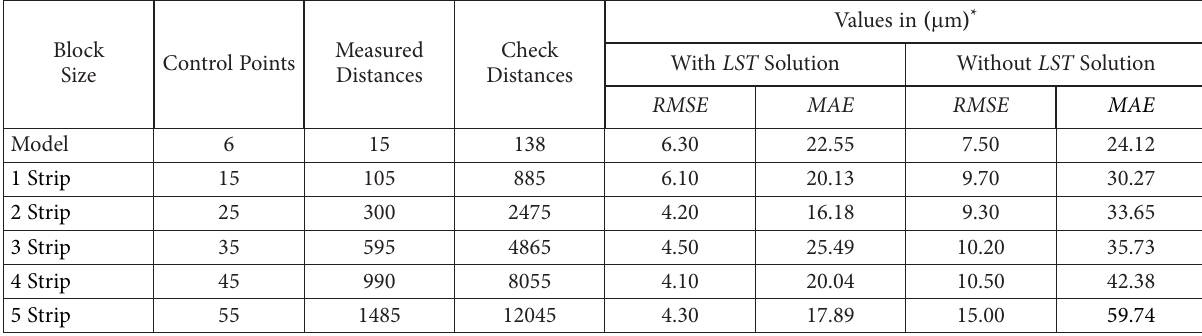
Table 2. Results of block adjustment with and without LST solution